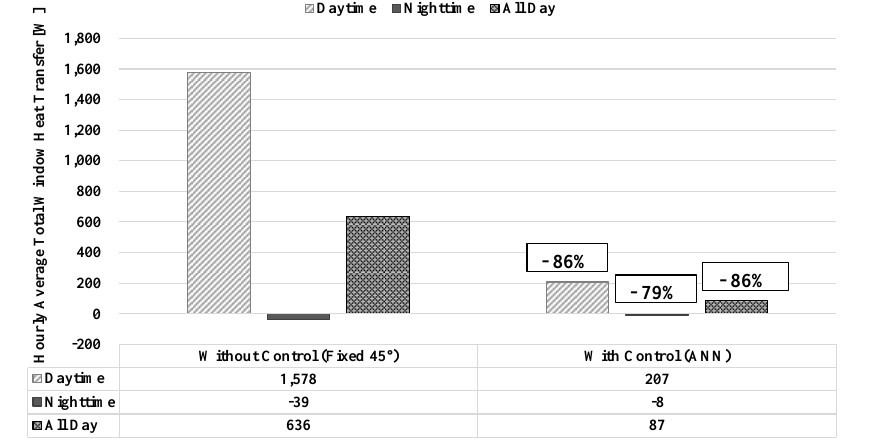
Figure 10. Hourly average total window heat transfer during the cooling period.